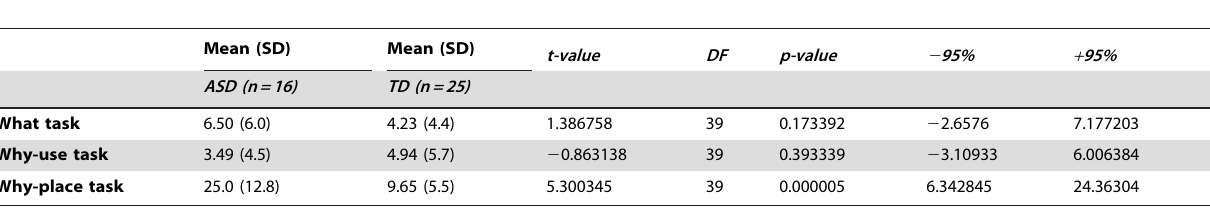
Table 3. Post-hoc comparisons in Experiment 1 between the error rates of the two groups in each of the 3 tasks.